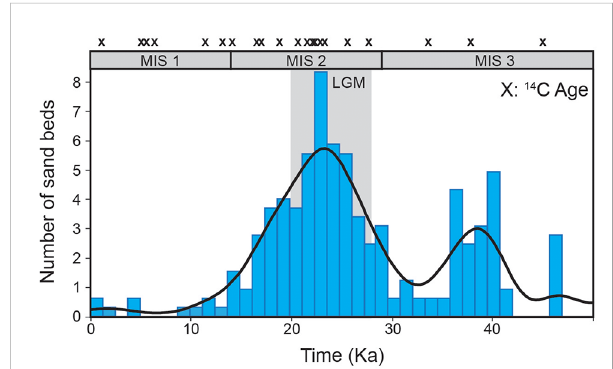
FIGURE 7 Kernel density estimate and histogram of sand occurrences over time from all sediment cores from the San Simeon Channel. Xs mark locations of radiocarbon ages used to calibrate the age regression for the sand beds. Note the increase in sand occurrences centered around the Last Glacial Maximum (gray rectangle; LGM). MIS 1 – 3, Marine Isotope Stages 1 – 3.